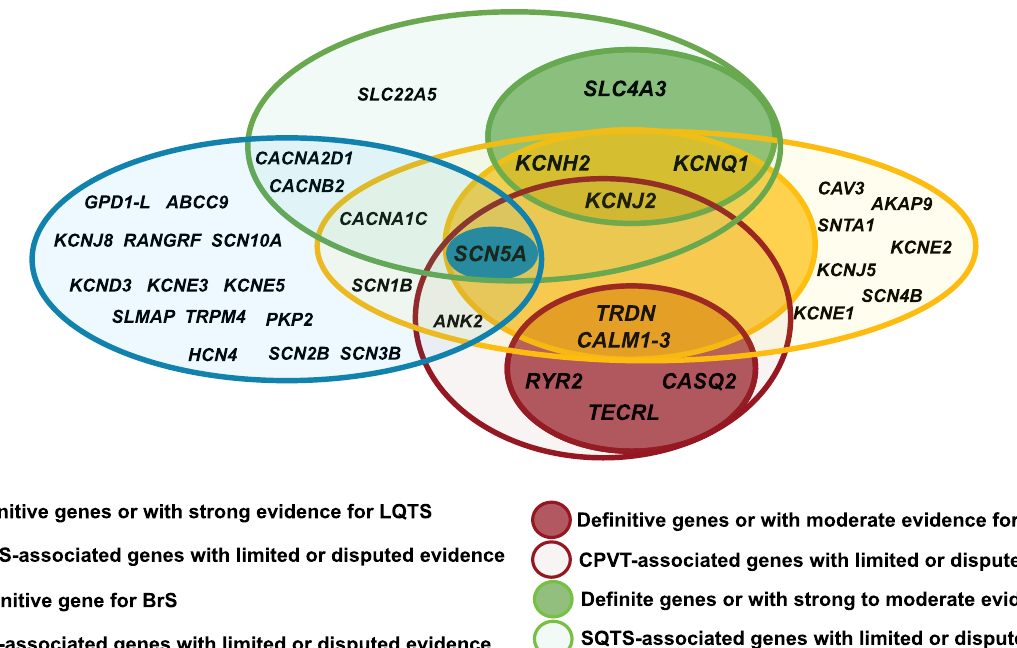
Figure 1. Diagram of the overlap between the genes IASs-associated genes: Brugada syndrome (BrS); short QT syndrome (SQTS); long short QT syndrome (LQTS) and catecholaminergic polymorphic ventricular tachycardia (CPVT).